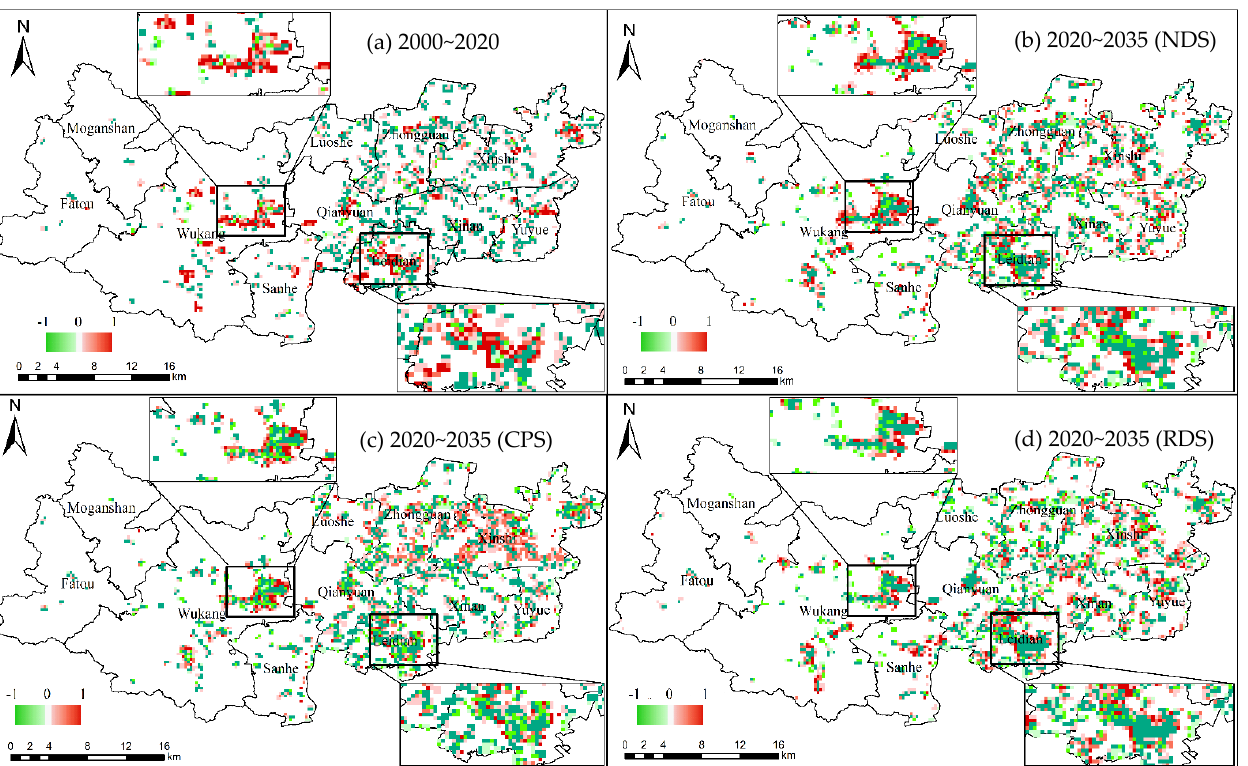
Figure 11. Expansion patterns for rural settlements in the key regions during 2000–2035 (NDS, CPS, and RDS).